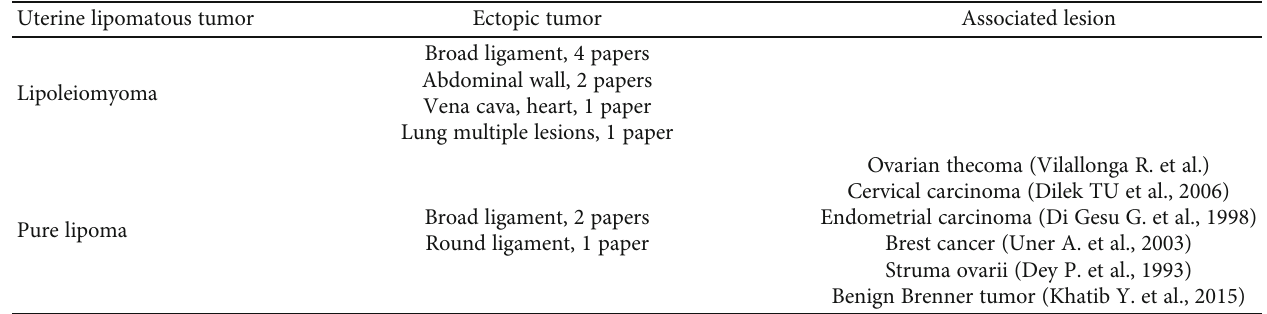
Figure 3: Microscopic fi ndings of the uterine lipoma and the left ovarian tumor: (a) microscopic visualization of fat cells in the uterine lipoma; (b) histological analysis of the mucinous portion of the left ovarian tumor; (c) histological analysis of the solid portion of the left ovarian tumor. Table 1: Variant and associated lesion of uterine lipomatous